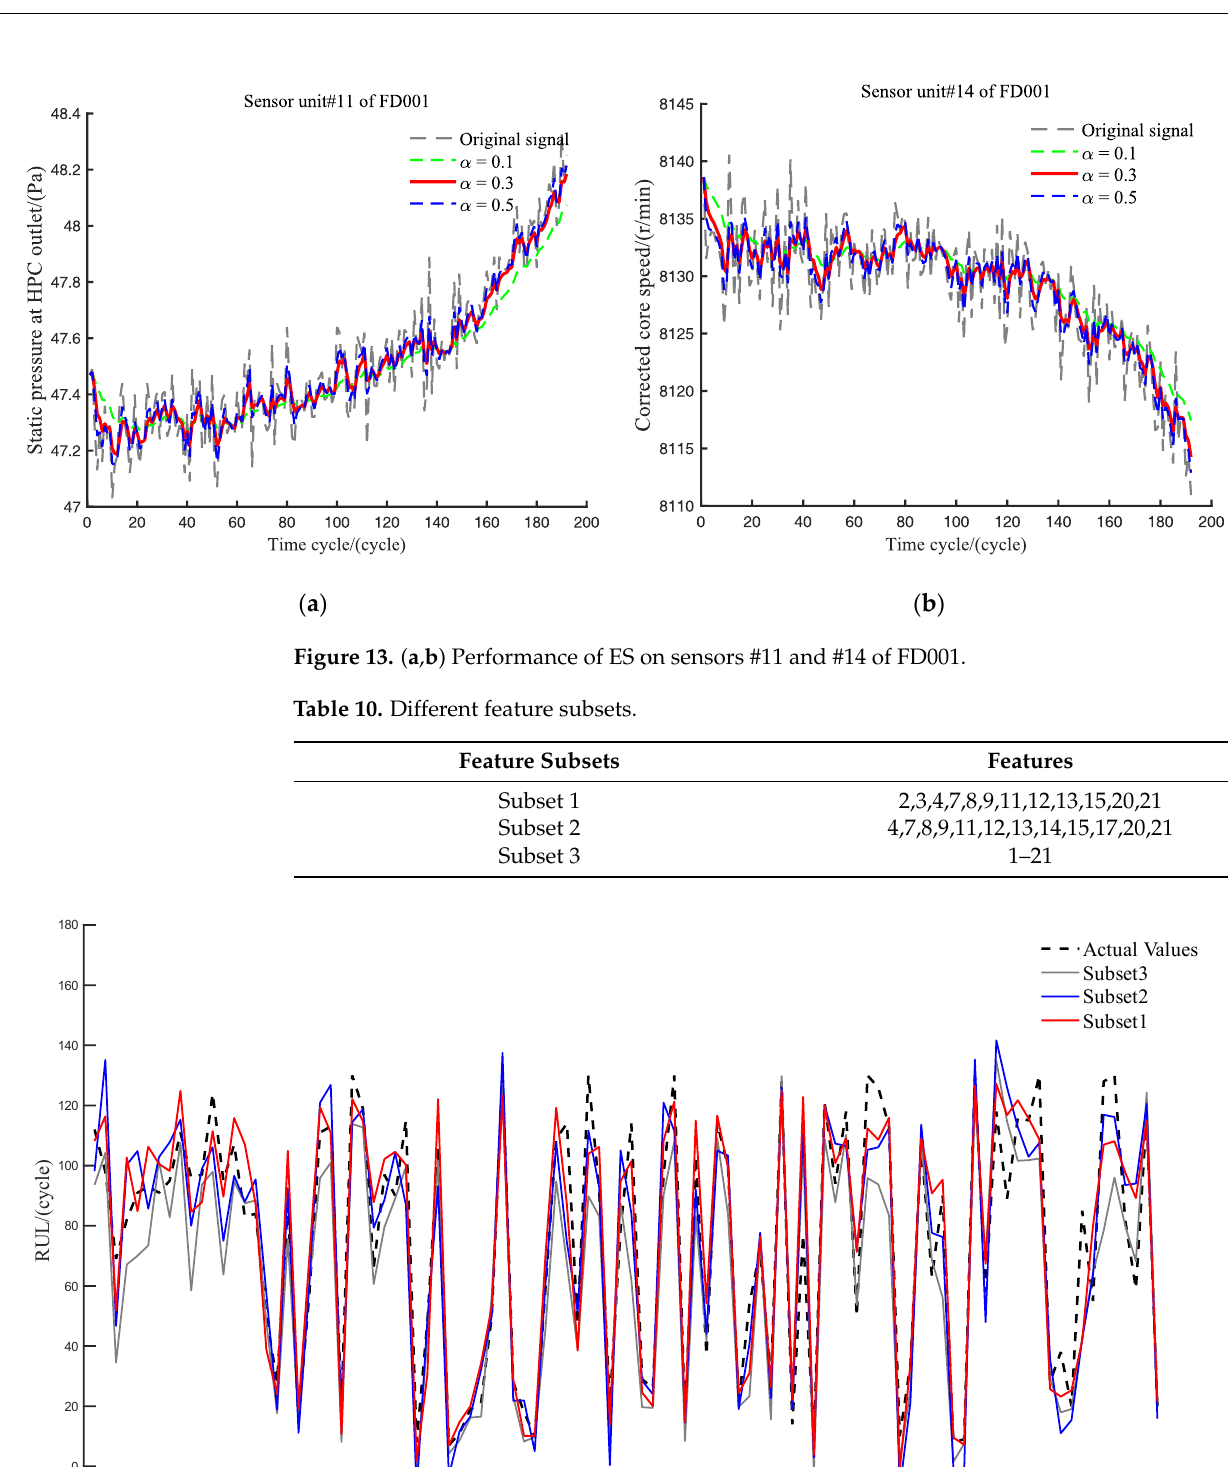
Table 10. Different feature subsets.